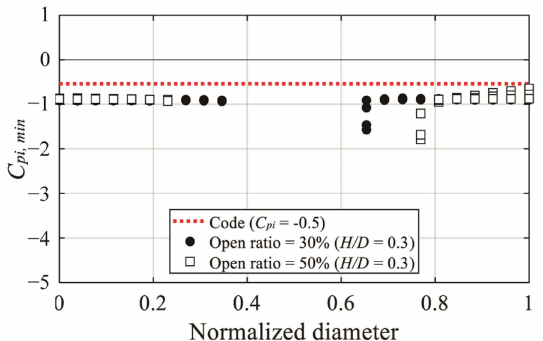
Figure 18. Comparison of the negative internal peak pressure coefficients of AIJ-RLB (2015).